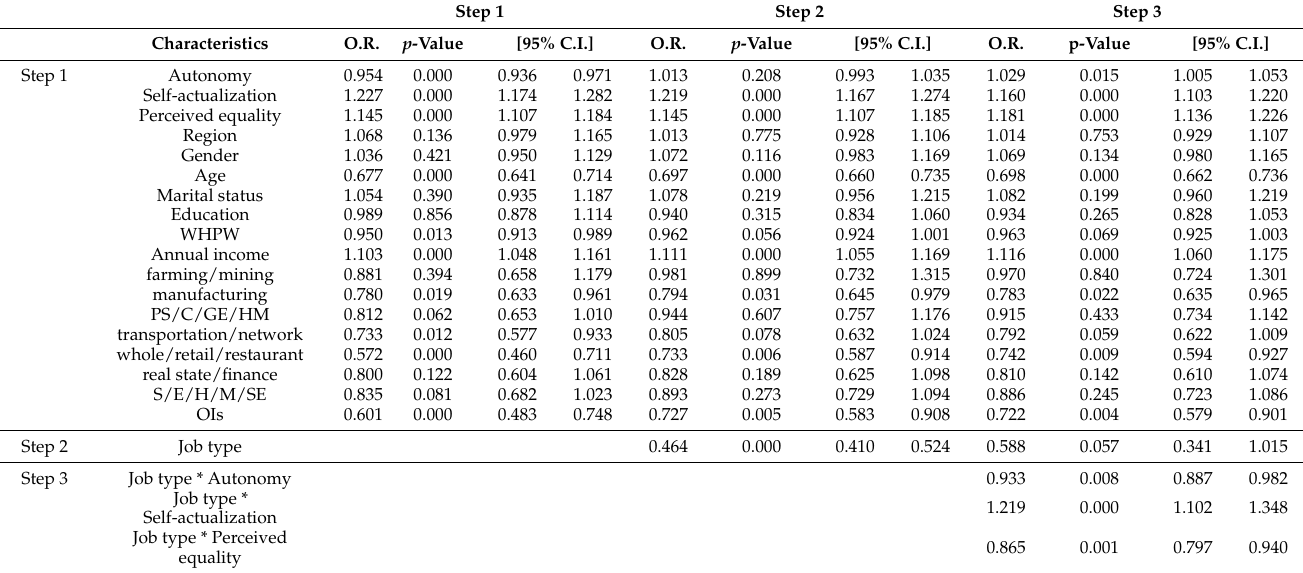
Table 6. Ordinal logistic regression of physical wellbeing in full sample by